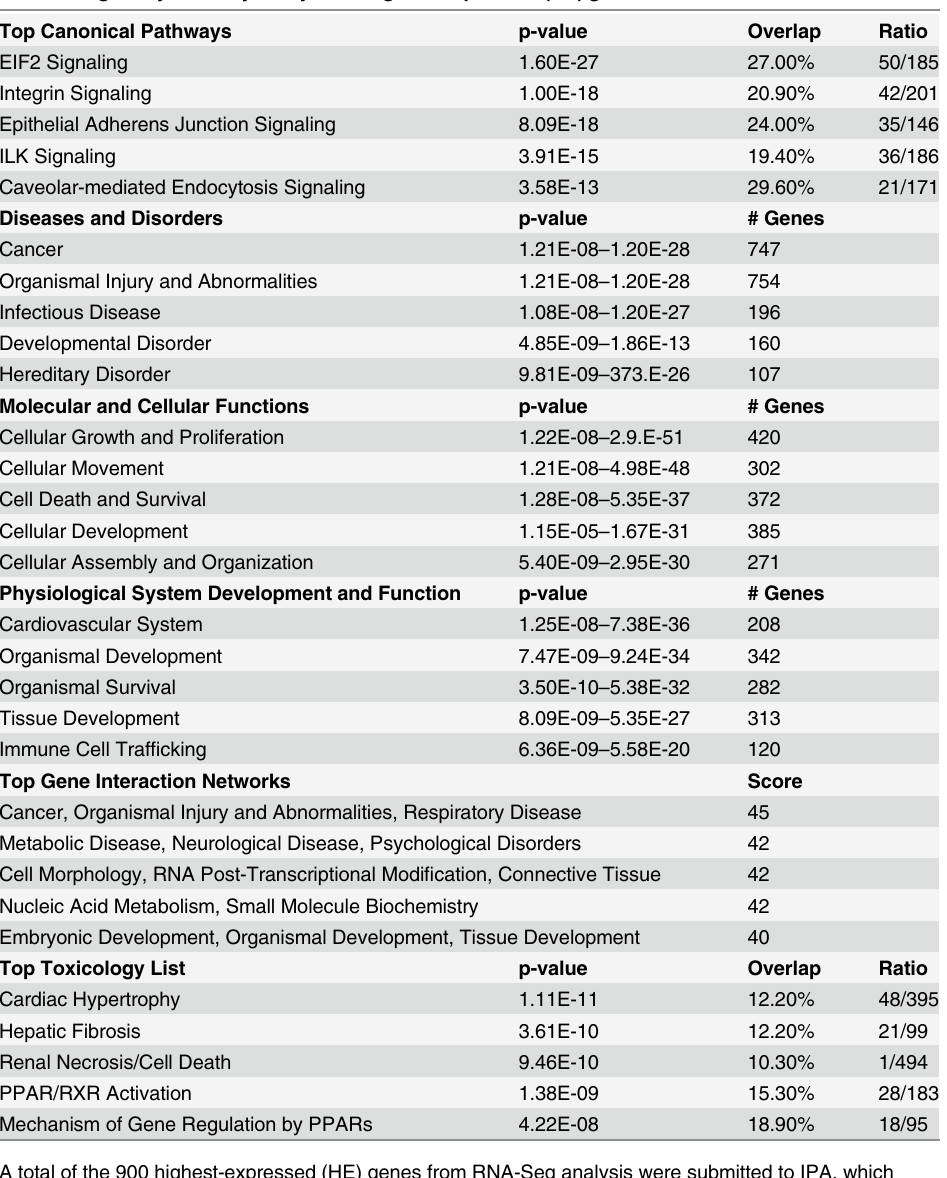
A total of the 900 highest-expressed (HE) genes from RNA-Seq analysis were submitted to IPA,